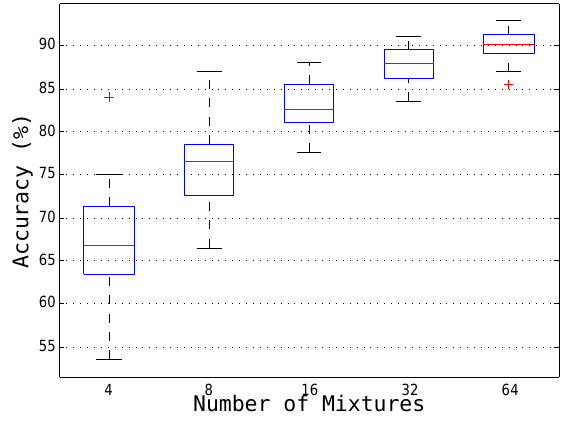
Figure A3. Boxplots showing the accuracy of the birdsong recognition algorithm considering a 2 n sweep of mixtures of the